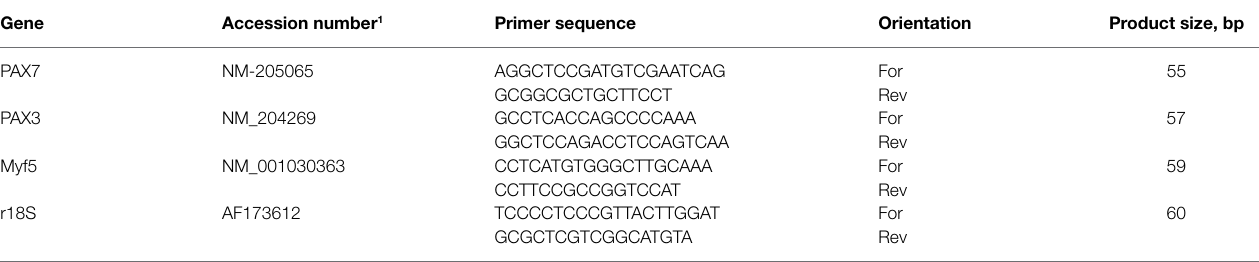
TABLE 1 | Oligonucleotide PCR/qPCR